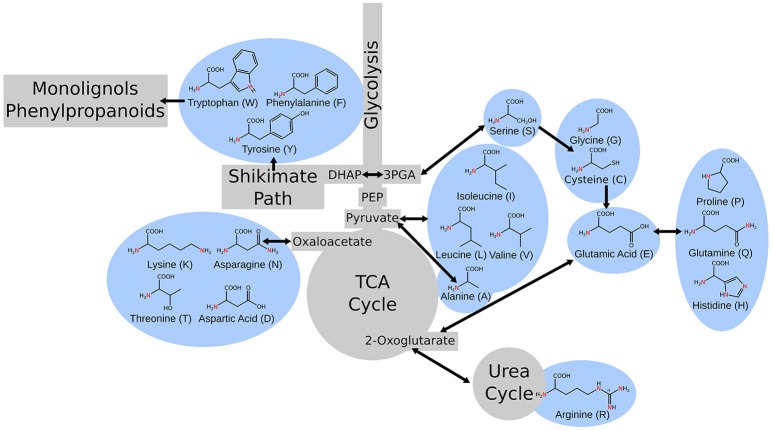
A simple schematic of central metabolism in the context of carbon flow showing the points where the metabolism of various amino acids intersect.